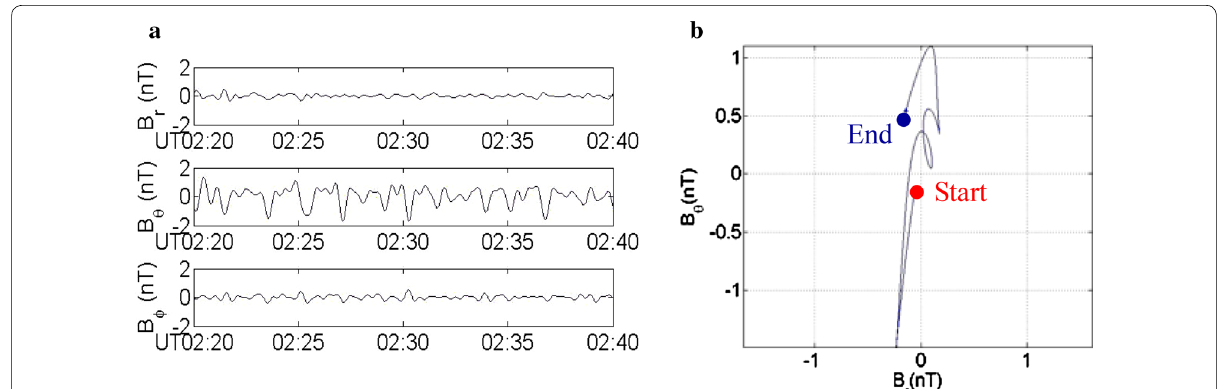
Fig. 6 A mirror-mode event for R outside 6 R S on March 9, 2005. a Perturbed magnetic field components in the KRTP coordinates, B 0 ~48 nT, and b the linear polarization in δ B θ . The red point denotes the start time and the blue point denotes the end